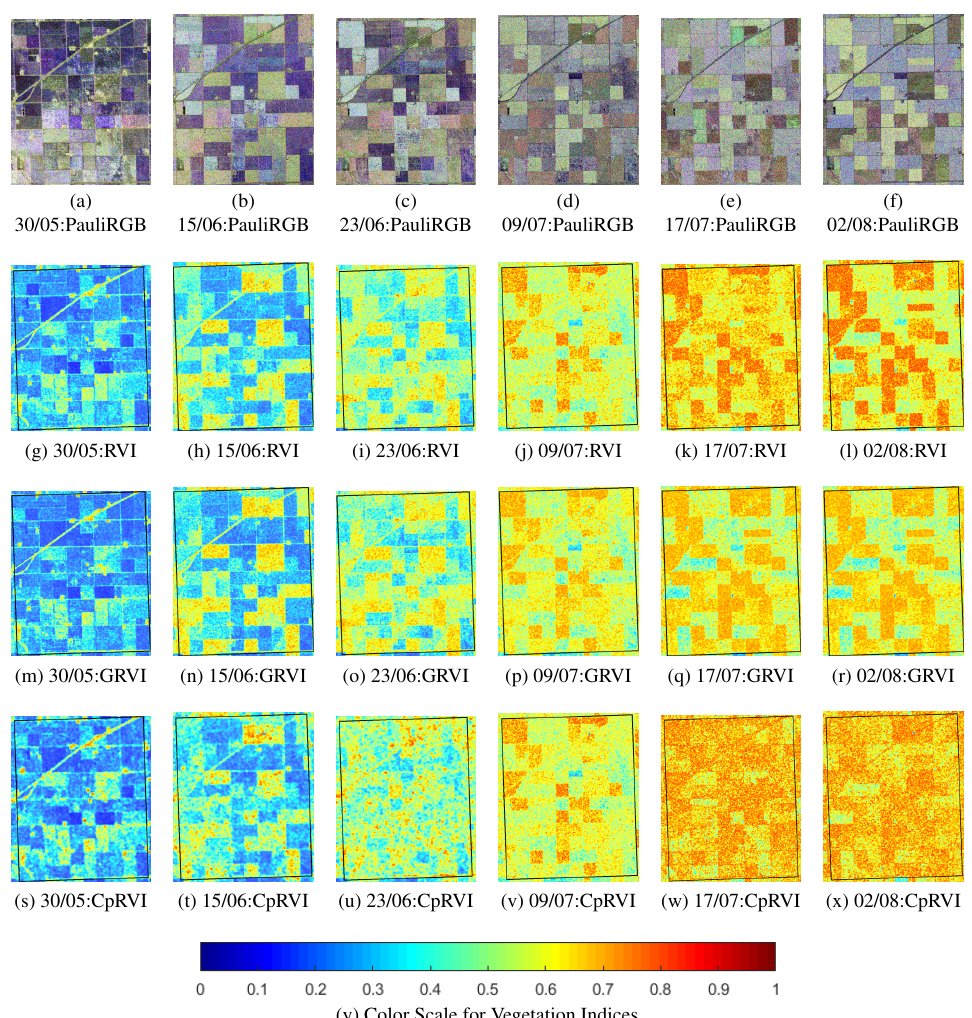
Figure 3. Evolution of Pauli RGB and the vegetation indices over time.